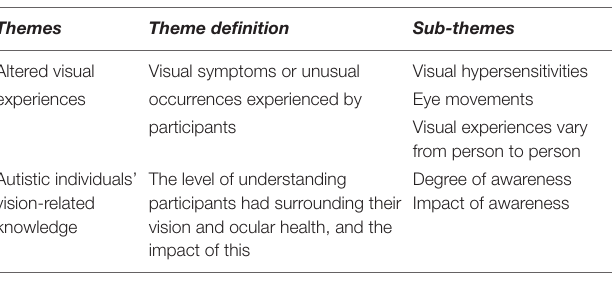
TABLE 1 | The six allocated themes and their definitions as well as respective subthemes, grouped according to the question from which they arose. Question 1: Does anybody feel they experience any visual problems or unusual visual